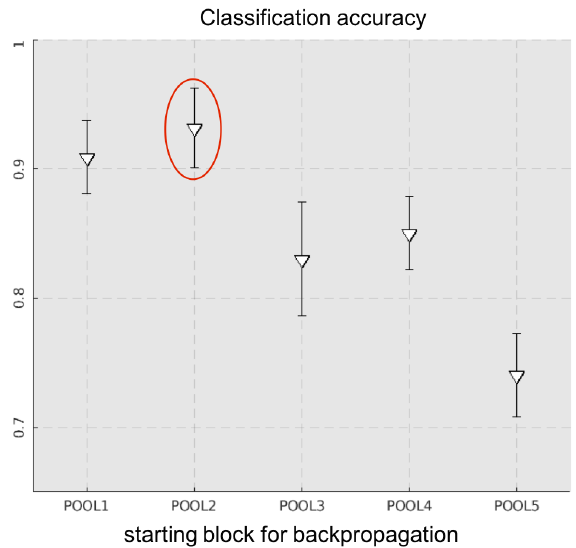
Figure 7. Optimization of the partial fine-tuning. Classification accuracy versus the starting block of the backpropagation (the bars extend from the minimum to the maximum accuracy value obtained by each of the five polyp categories).